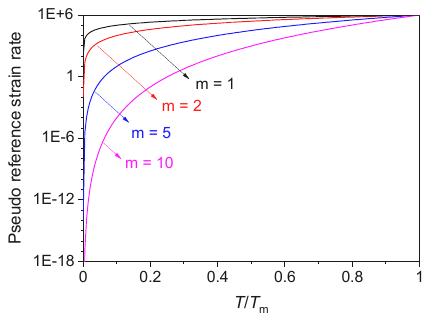
. . ε 0 ) when ε 0 vd = 10 − 6 s − 1 for a range